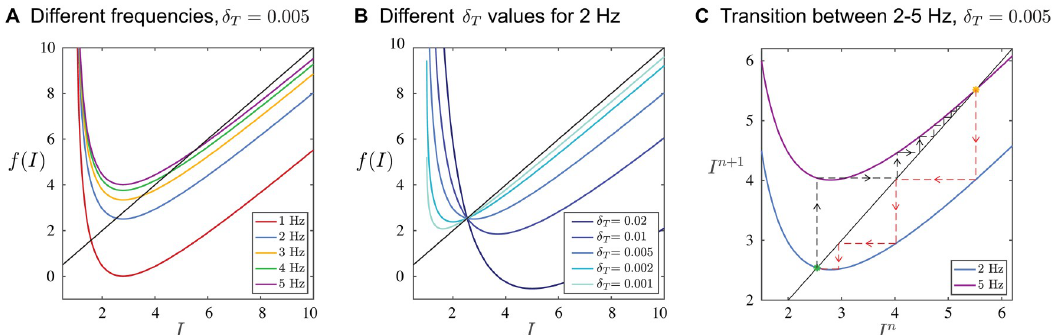
Fig 4. One-dimensional map for period matching illustrated using the LIF model. A . Plots of the map for different frequency stimulus are shown. Each curve crosses the diagonal at exactly one point, corresponding to a fixed point of the map. The slope at this intersection determines stability. As frequency increases, the fixed point moves up and gains stability. B . For the case of 2 Hz, as δ increases, stability is lost. Similar results hold for any stimulus frequency. C . A cobweb diagram of the convergence of a trajectory is shown. Initially, the black trajectory starts at a value corresponding to a 2 Hz oscillation. Then I bias is shifted to a value corresponding to a 5 Hz oscillation. The trajectory cobwebs over a number of cycles until it converges to the new stimulus frequency. The opposite transition from 5 Hz to 2 Hz is shown in red and occurs over less